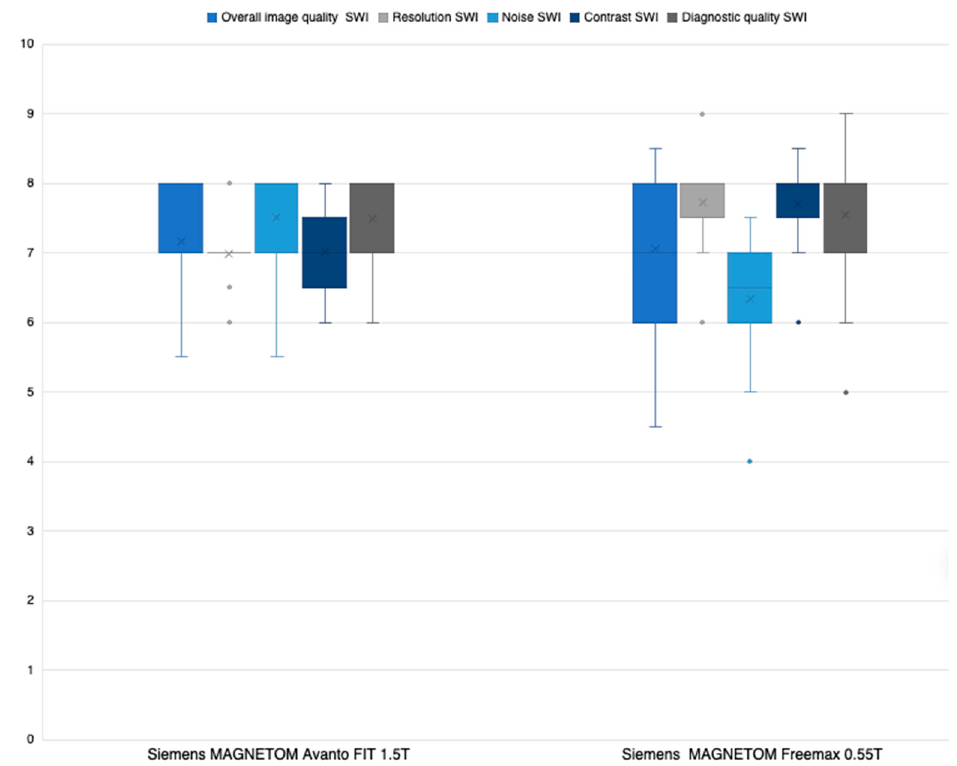
Figure 1. Average Likert scoring of Readers 1 and 2 SWI sequences.